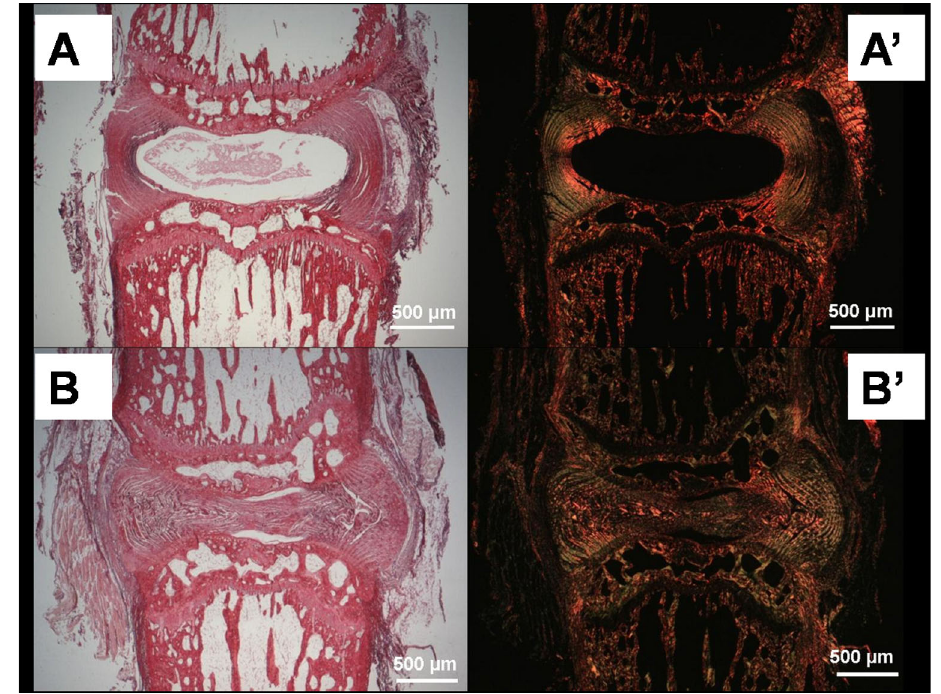
Figure 6. Collagen fiber orientation was assessed using picrosirius red staining and examined under polarized light. The upper panel shows a control intervertebral disc ( A ) and the same disc viewed by polarizing microscopy ( A 9 ). The lower panel shows the same condition with a lesioned disc ( B and B 9 ). Collagen type I fibers are shown in green in the annulus fibrosus, and collagen type II fibers are shown in red. Proliferation of collagen type I fibers was detected in the nucleus pulposus space of a lesioned